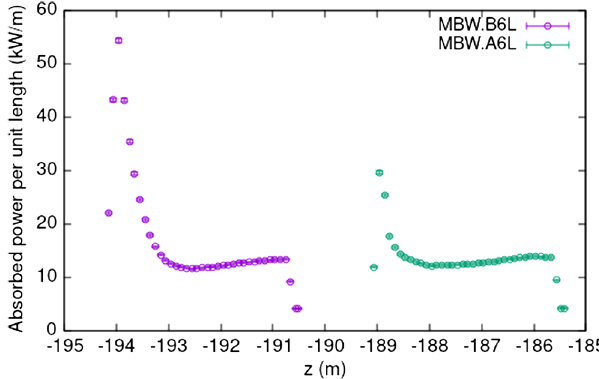
FIG. 4. Power density 3D distribution on the most exposed secondary collimator for 0.2 h BLT.